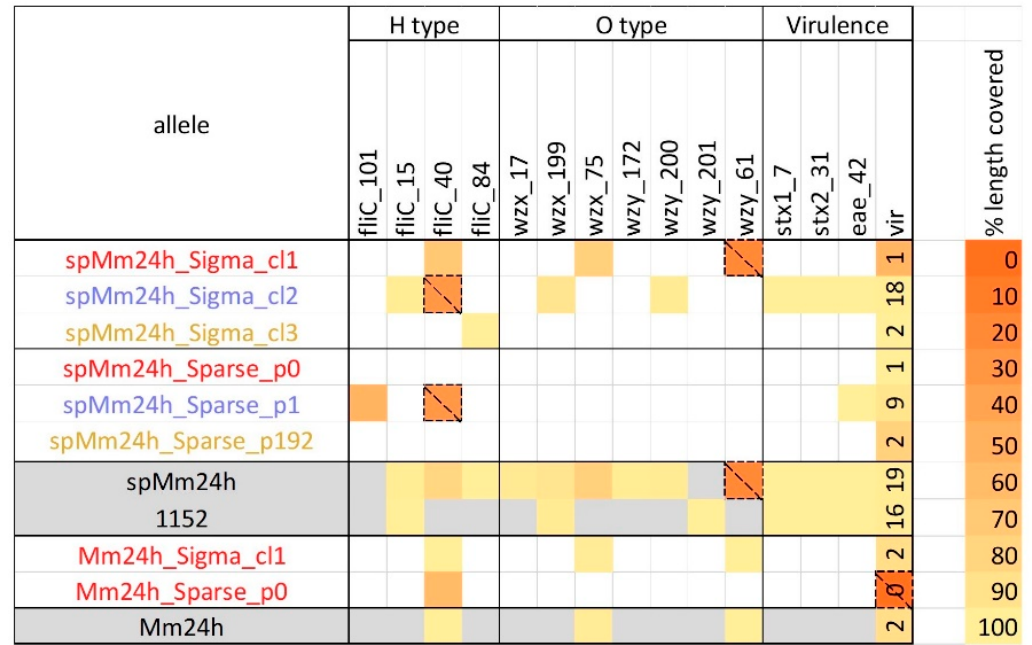
Figure 2. Gene detection of the O- and H-type serotyping and virulence genes performed on the clusters detected by Sigma and Sparse in the spiked (spMm24h) and unspiked (Mm24h) enriched